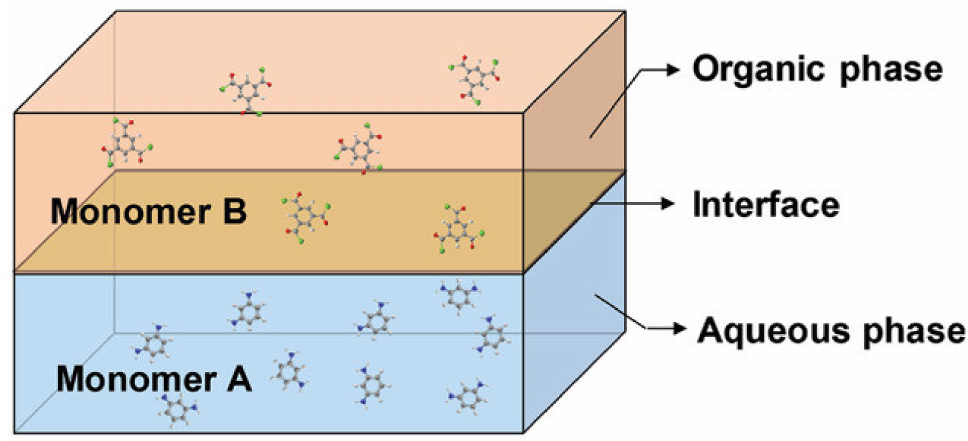
Figure 7. Schematic illustration of IP. Reprinted with permission from Ref. [34]. Copyright 2020, John Wiley and Sons.